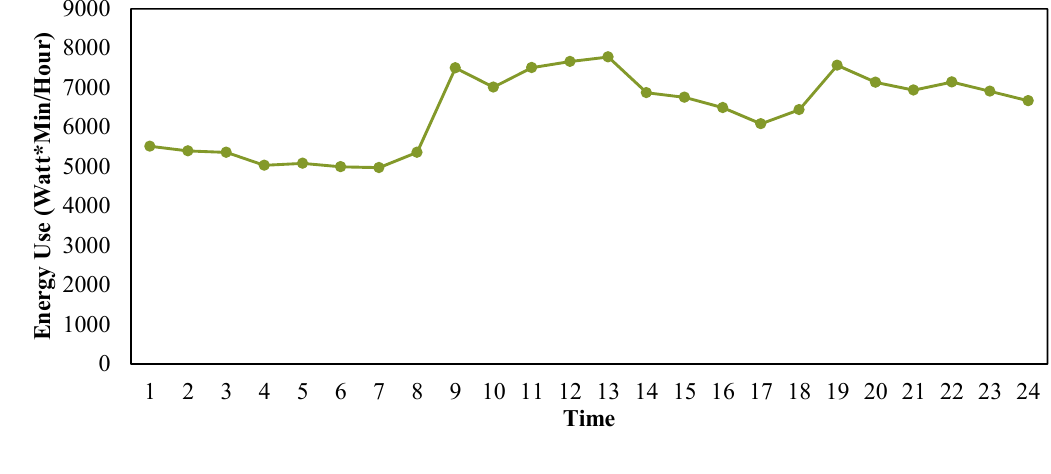
Figure 4. Hourly average energy